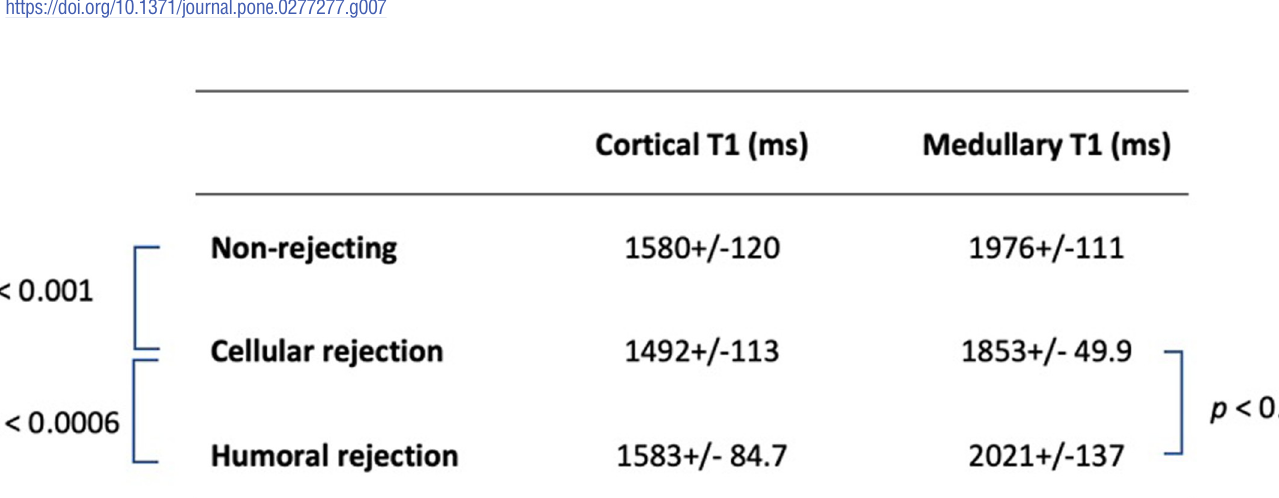
PLOS ONE | https://doi.org/10.1371/journal.pone.0277277 February 15, 2023 15 /